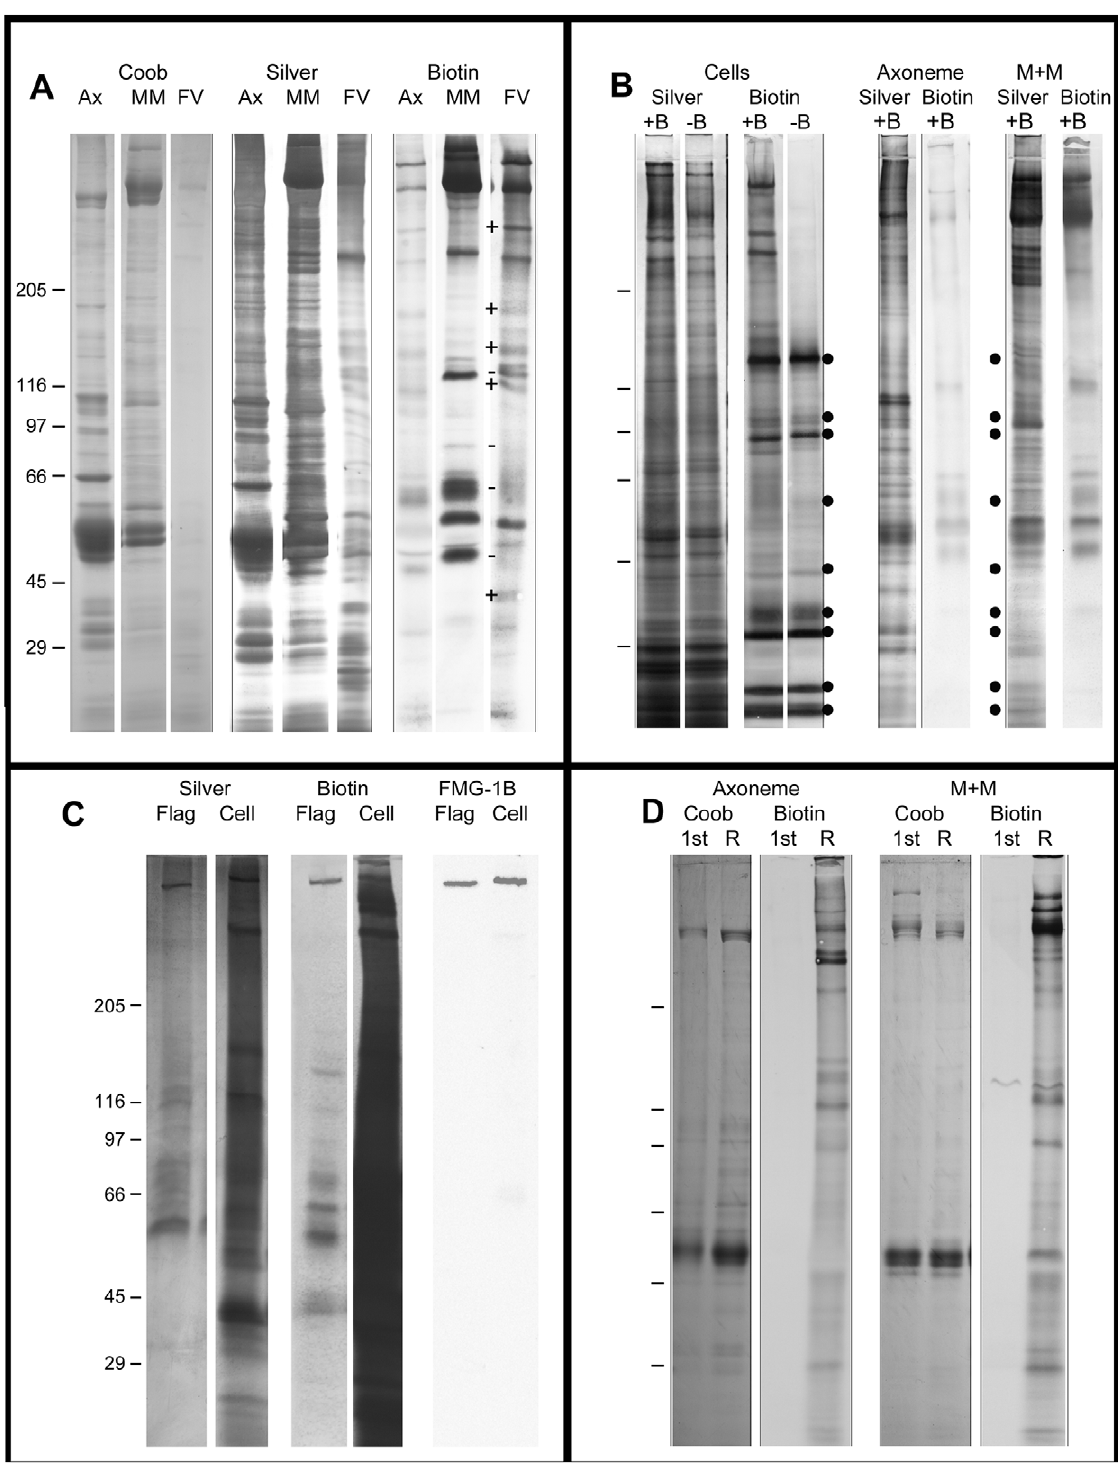
Figure 2. Analysis of control and biotinylated Chlamydomonas cells, purified flagellar vesicles shed into the medium, and the detergent-insoluble axonemes and detergent-solubilized membrane + matrix from purified flagella. A. Composition of FV compared with axonemes and membrane + matrix. ‘‘ + ’’ and ‘‘ 2 ’’ refer to the relative quantity of biotinylated proteins in the membrane + matrix (MM) and the flagellar vesicles (FV). B. Identification of endogenously biotinylated proteins in cells but not flagella. Biotinylated ( + B) and non-biotinylated ( 2 B) cells were deflagellated. Black dots mark endogenously biotinylated bands. These were not found in flagellar fractions or in FV (compare B with FV in A). C. Biotinylated proteins from flagella and deflagellated cells were affinity-purified by avidin chromatography and separated by SDS-PAGE. Identically loaded blots were stained with AP-streptavidin (Biotin) or antibodies against FMG-1B. D. Flagella isolated from non-biotinylated cells (1 st ) contained no endogenously biotinylated bands. Deflagellated cells were biotinylated and allowed to regenerate flagella. Regenerated flagella contained the same biotinylated proteins seen when flagellated cells were biotinylated. doi:10.1371/journal.pone.0053366.g002 PLOS ONE | www.plosone.org 4 January 2013 | Volume 8 | Issue 1 |